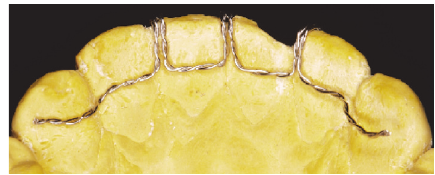
Figure 5: Lingual view of the appliance.